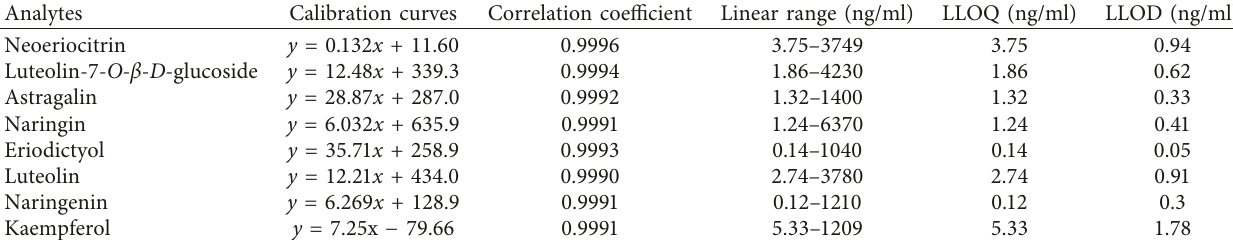
Table 2: Regression data, LLOQ, and LLOD of eight analytes.